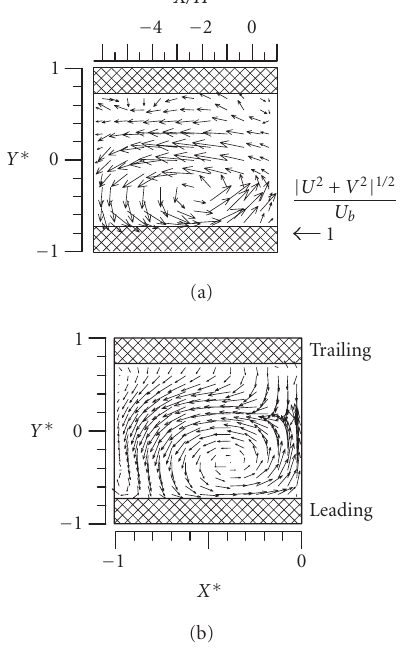
Figure 5: Cross-stream secondary flow patterns in the mid-turn ( Z ∗∗ = 0) for Ro = 0 . 15 and Re = 1 . 0 × 10 4 : (a) Liou et al. [1] and (b) present study.